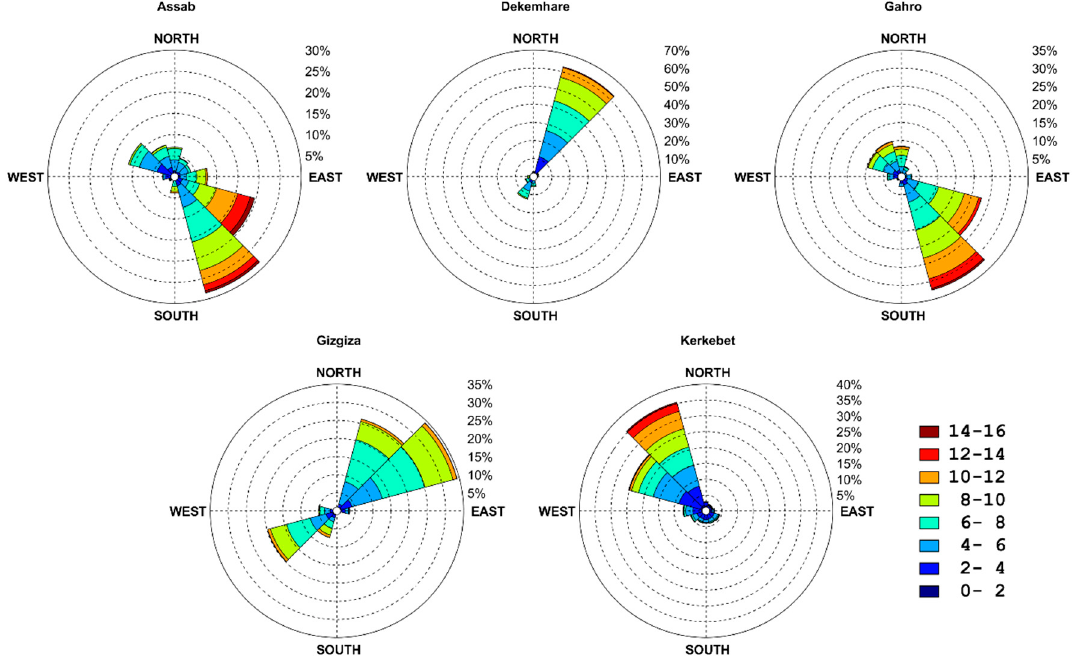
Figure 7. Wind roses for the year 2000 for the five sites deemed as most potential.